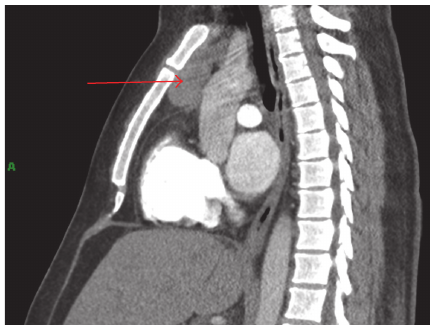
Figure 5: (PET) no significant metabolic activity in the anterior mediastinal mass (yellow arrow).